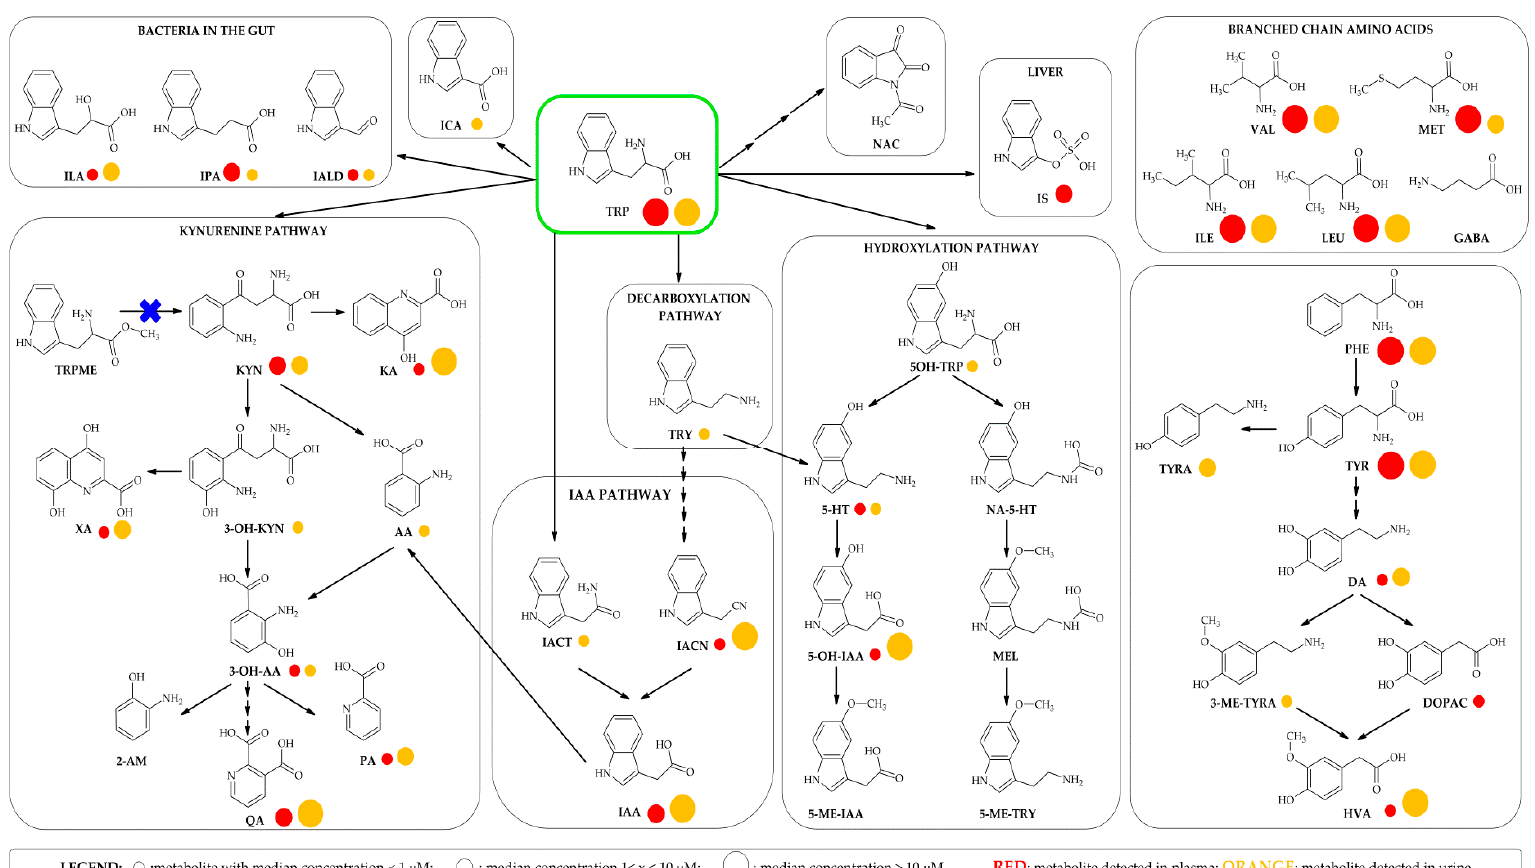
Figure 1. Principal branches of the TRP and TYR metabolic pathways covered in this analytical method and structures of the main BCAAs. Red circles represent the metabolites detected in plasma, orange circles those detected in urine. The size of the circle is proportional to the median concentration in each biofluid. : metabolite with median concentration of < 1 μ M; : metabolite with median concentration of 1 < x < 10 μ M; : metabolite with median concentration of > 10 μ M.